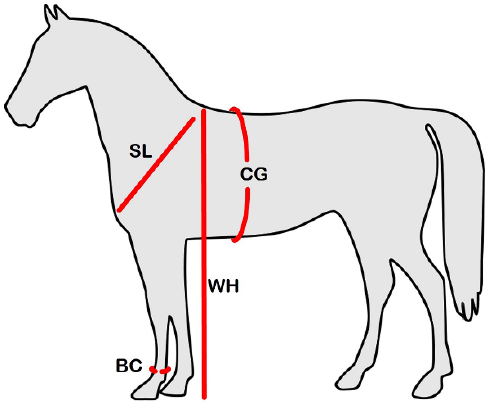
Figure 1. The four body measurements detected in Sardinian Anglo-Arab horse (SAA). BC = Cannon Bone Circumference; CG = Chest Girth; SL = Shoulder Length; WH = Withers Height.